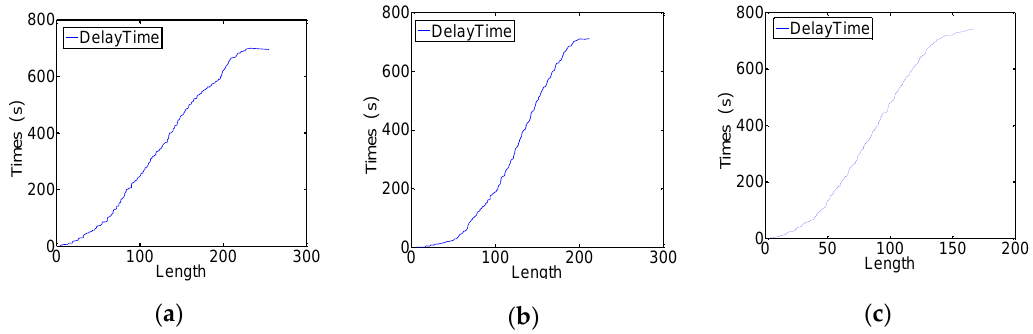
Figure 16. The relationship of the evacuation path length and the delayed departure time of all groups in each zone when evacuation density is large. ( a ) Zone E1; ( b ) Zone E2; ( c ) Zone E3.